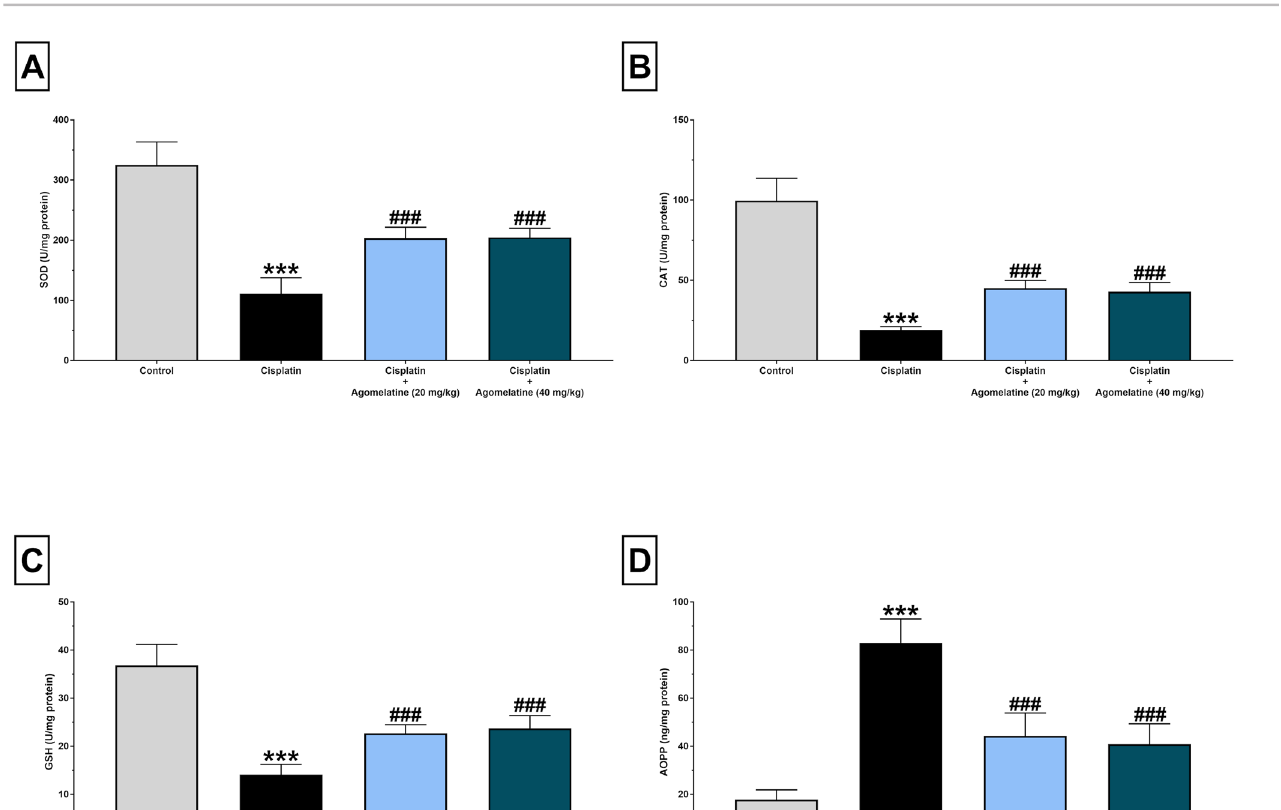
FIGURE 3 - Levels of antioxidant and oxidant markers in liver tissue. A: Superoxide dismutase (SOD), B: Catalase (CAT), C: Glutathione-S-hydroxylase (GSH), D: Advanced oxidation protein products (AOPP). Agomelatine 20 mg/kg significantly attenuated cisplatin-induced oxidative stress and resulted in a decrease in antioxidant enzymes. But, agomelatine at the dose of 40 mg/kg failed to protect liver tissue against cisplatin insult. All data represented as mean±SD and stand for five animals per group. *** p<0.001 versus control group and ### p<0.001 versus cisplatin group and +++ p<0.001 versus cisplatin+agomelatine (20 mg/kg)